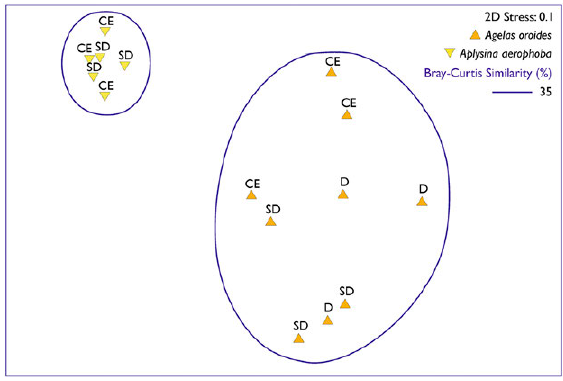
Fig. 4. – Resemblance of sponge-associated assemblages of the sponge species Agelas oroides and Aplysina aerophoba , collected from distinct cave zones (CE: entrance, SD: semidark zone, D: dark zone).